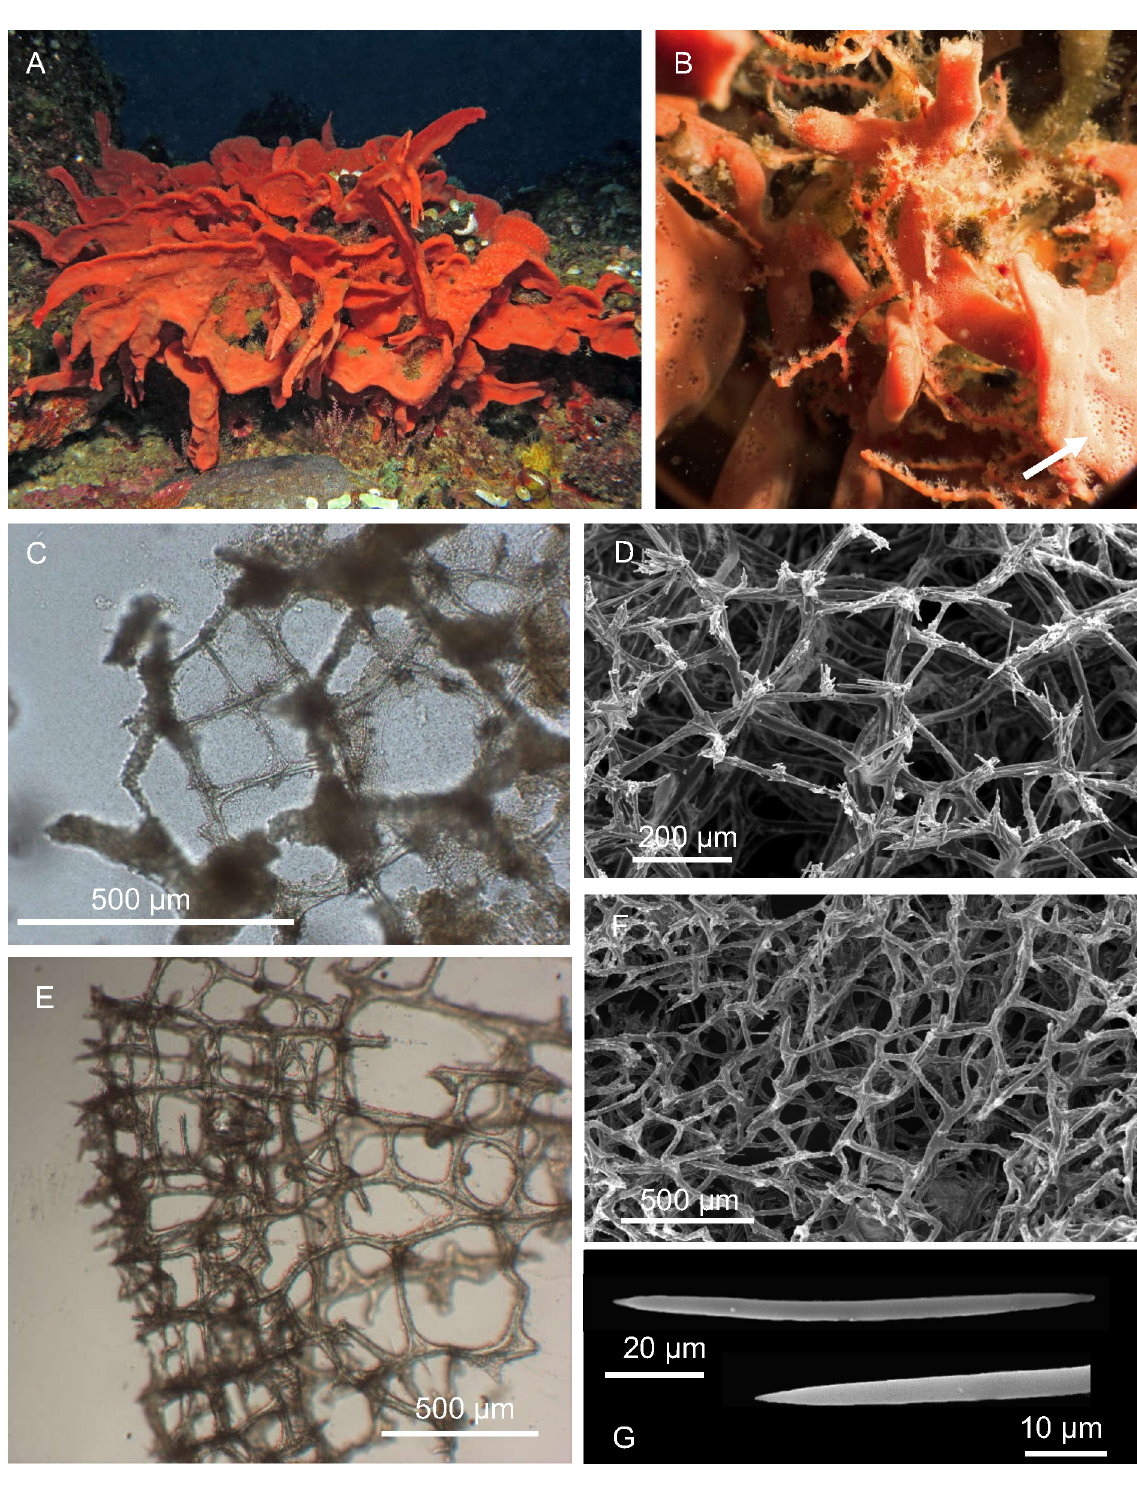
Fig. 7. Callyspongia ( Euplacella ) abnormis Pulitzer-Finali, 1993. A . The specimen PO30 in situ . B . Magnification of the specimen PO5, with groups of roundish vents in evidence (arrow). C . Ectosomal skeleton. D . SEM picture of the ectosomal skeleton. E . Choanosomal skeleton. F . SEM picture of the choanosomal skeleton. G . Oxea and magnification of the